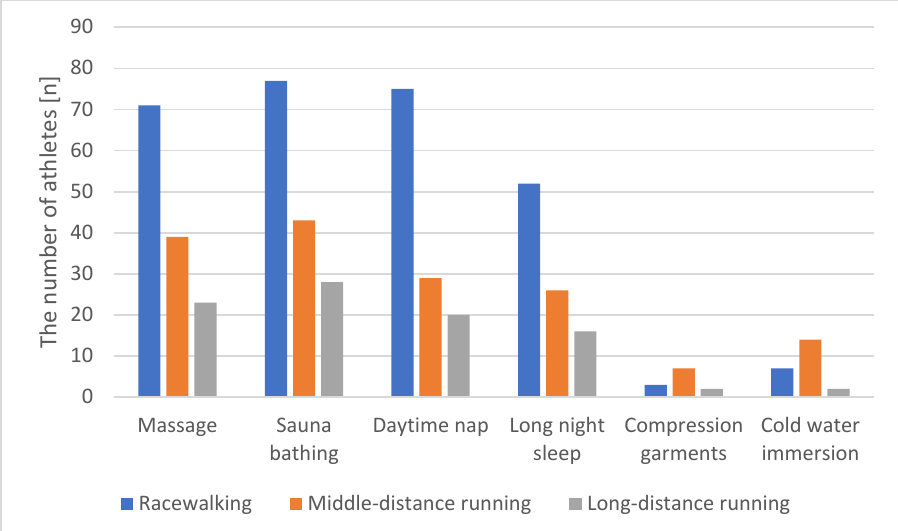
Figure 2. The use of recovery technique according to athletes’ discipline.